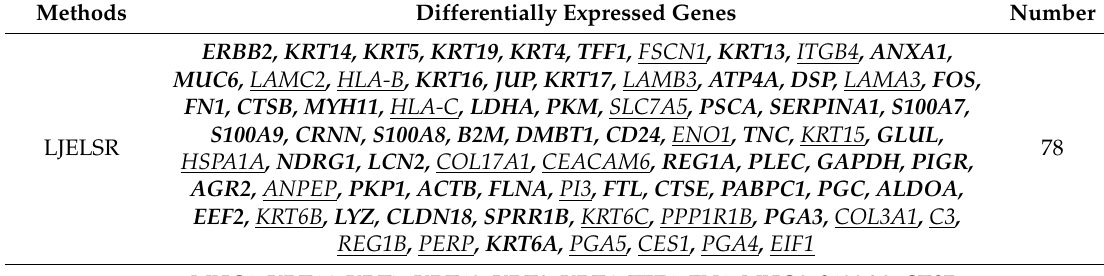
Table 8. Differentially expressed genes of four methods for the ESCA